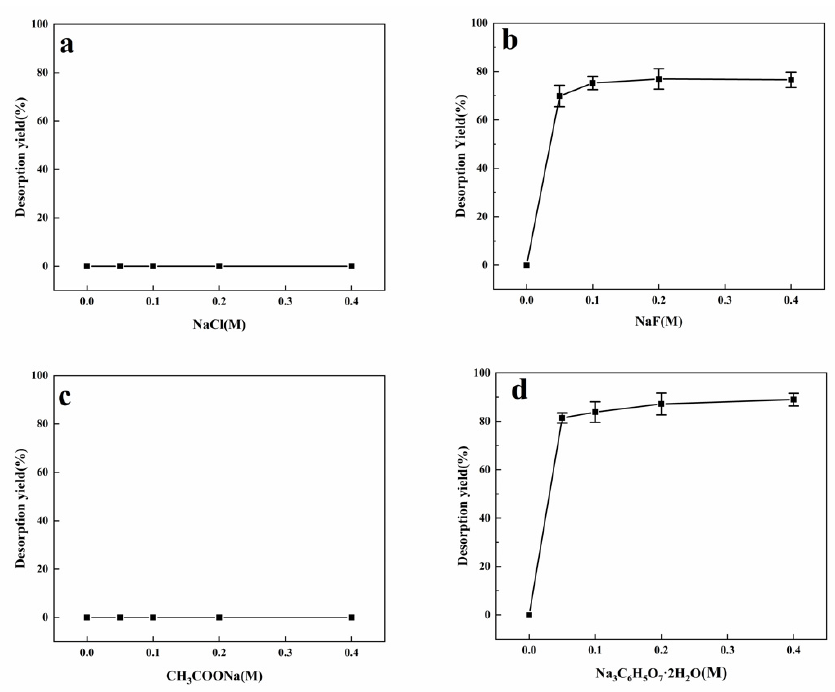
Figure 3. Desorption of dextranase from hydroxyapatite (HA) by ( a ) NaCl, ( b ) NaF, ( c ) CH 3 COONa, and ( d ) Na 3 C 6 H 5 O 7